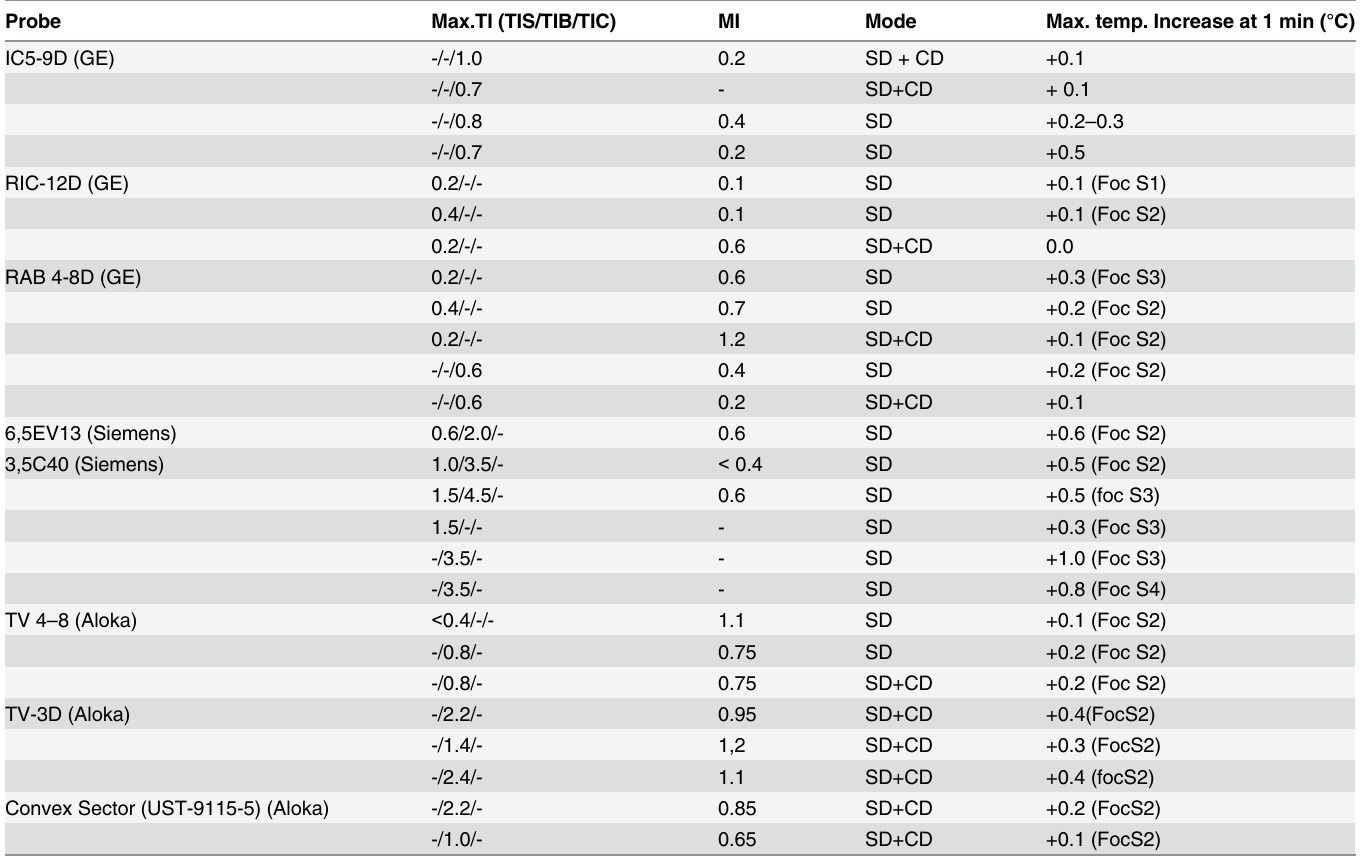
Table 2. Water bath model. Maximal temperature increase after 1 minute at different TI/ MI settings. Probe